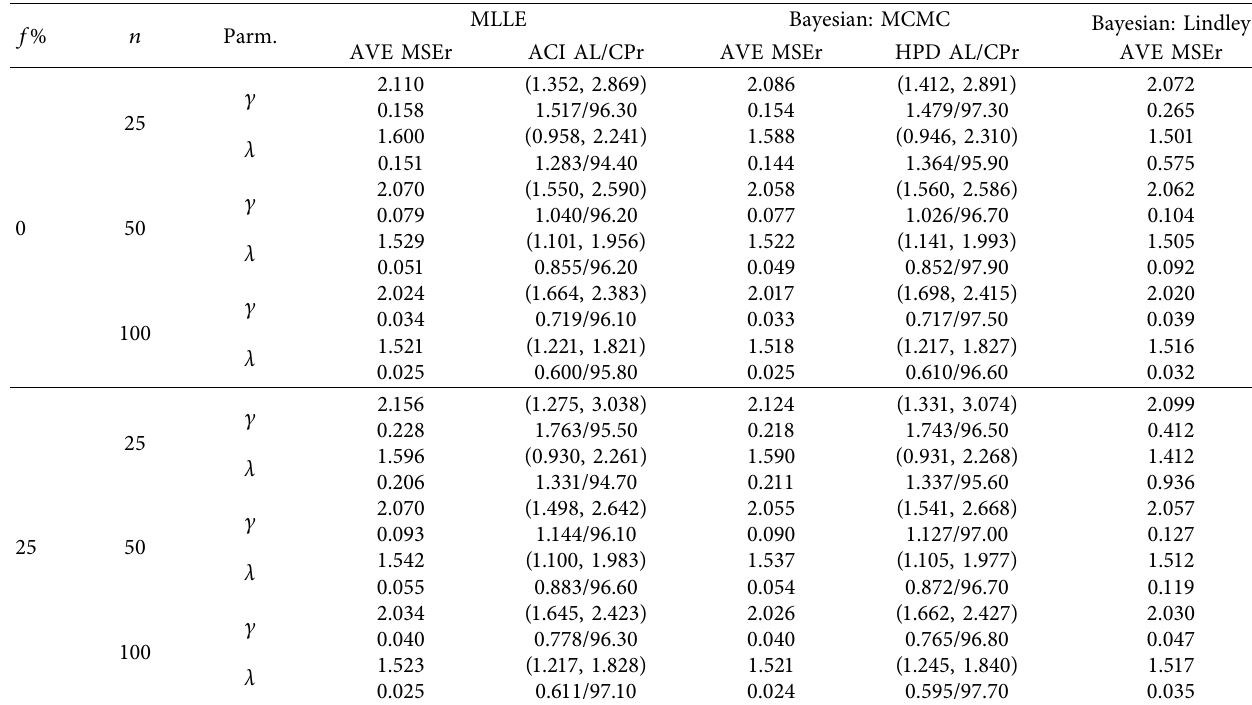
Table 3: Numerical results of AVEs, ACIs, MSErs, ALs, and CPrs (in %) for c � 2 and λ � 1 . 5 under number of stages m � 5. f % n